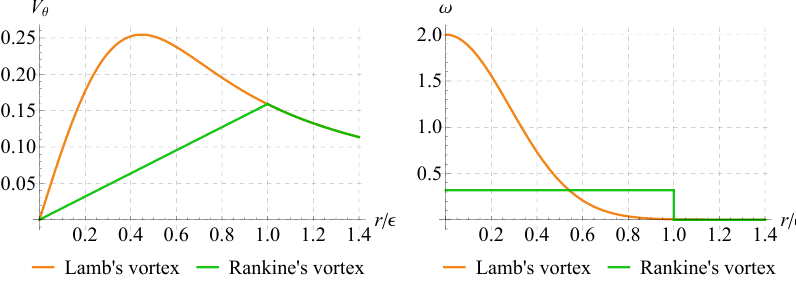
Figure 1. Circumferential velocity induced by Rankine’s and Lamb’s vortices with unit circulation and vorticity distributions; (cid:101) is Rankine’s vortex radius, Lamb’s vortex parameters are such that more, than 0.998 of total vorticity is inside the (cid:101) -circle; difference of velocities at r / (cid:101) > 1 is less than 0.2%. Vorticity in the free vortex sheet is assumed to be represented as some distribution— piecewise-constant or piecewise-linear over rectilinear parts of the discretized airfoil’s contour, which we hereinafter call “panels” (Figure 2). Similar piecewise-constant or piecewise-linear representation is considered also for the attached vortex and source sheets.